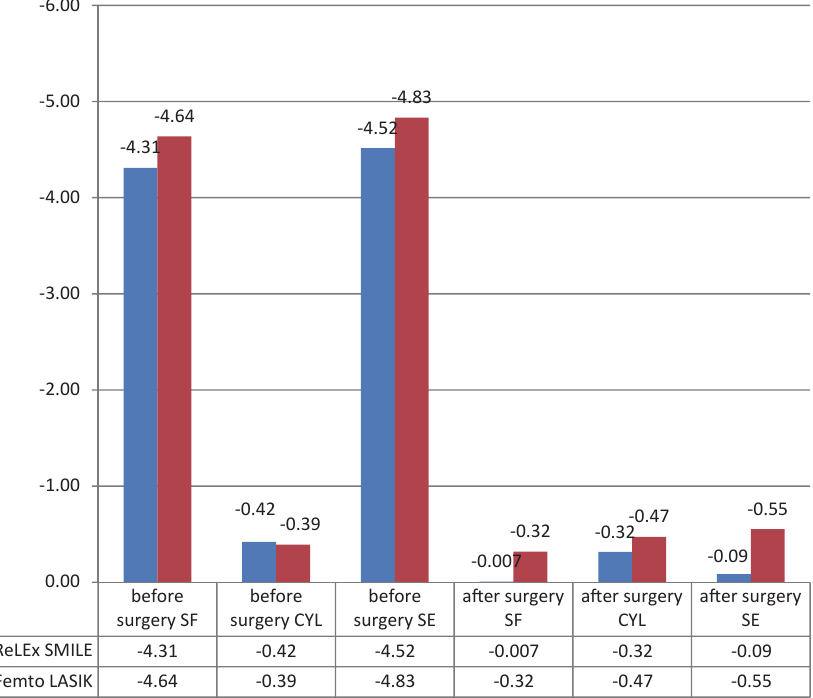
Fig. 3. The average values collected from automatic refractometer before and after surgery using femtoLASIK and ReLEx SMILE. X axis: representation of diopters before and after surgery. Y axis: dioptric